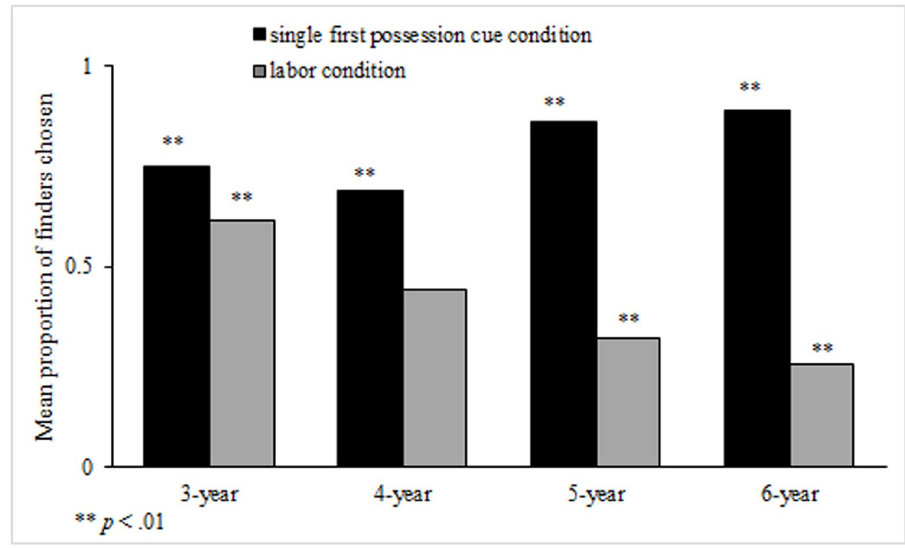
Fig 2. Choices of discoverers over modifiers in Study